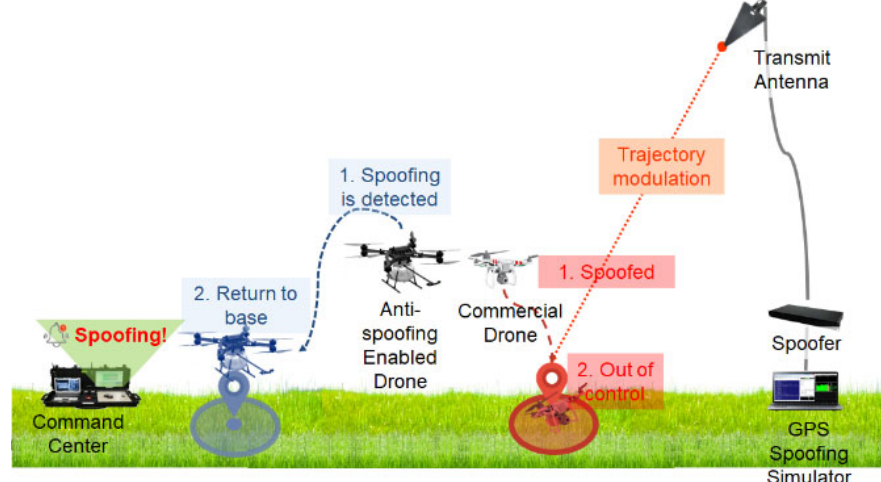
Figure 10. Spoofing test scenario.